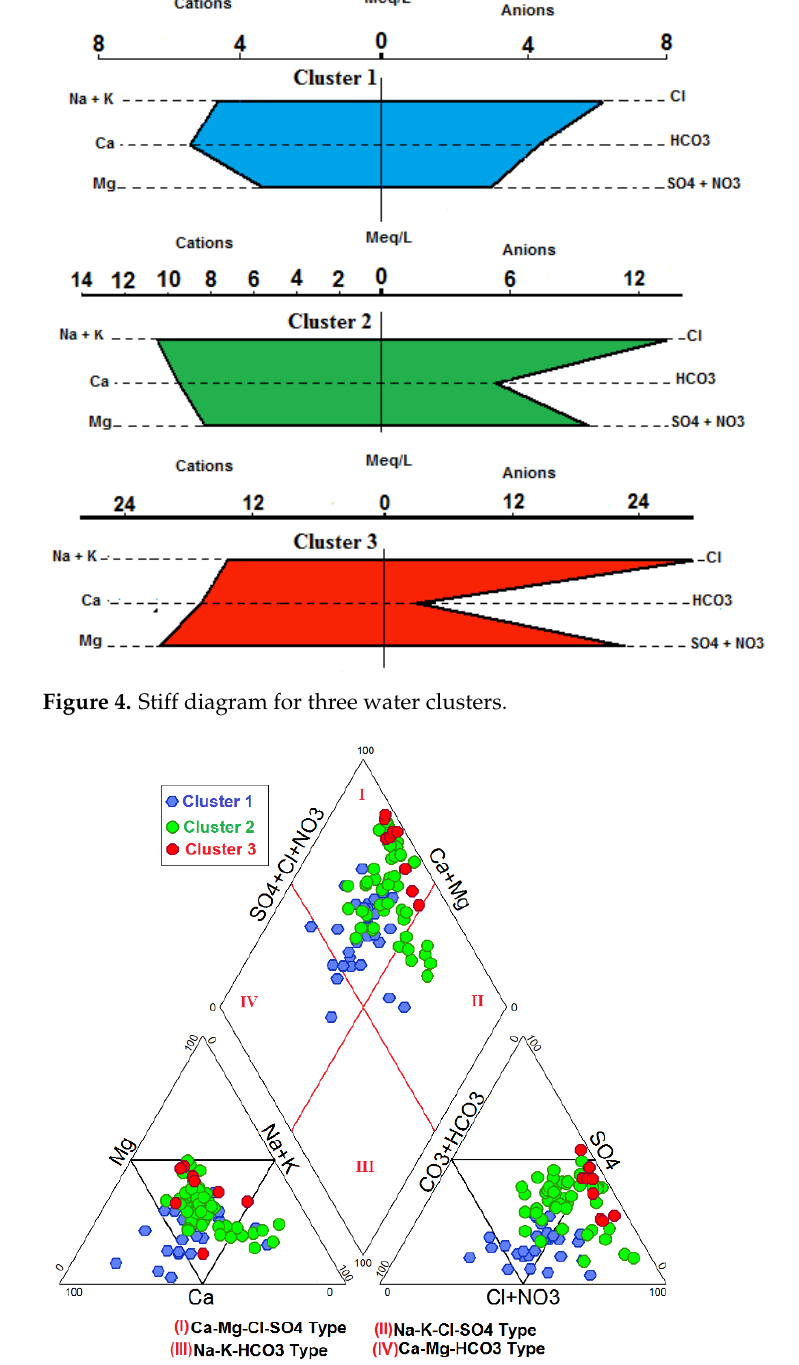
Figure 5. Piper diagram for water samples.